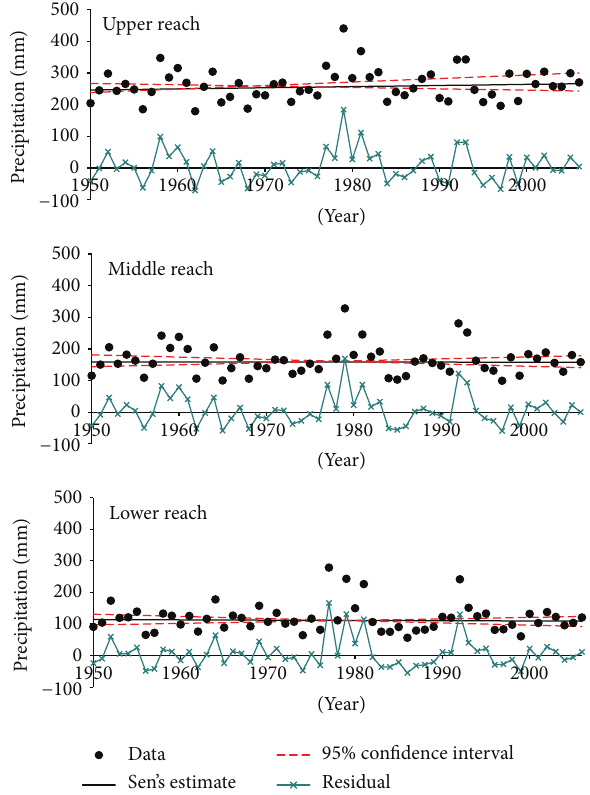
Figure 2: Sen’s slop estimate for annual precipitation in the Heihe River